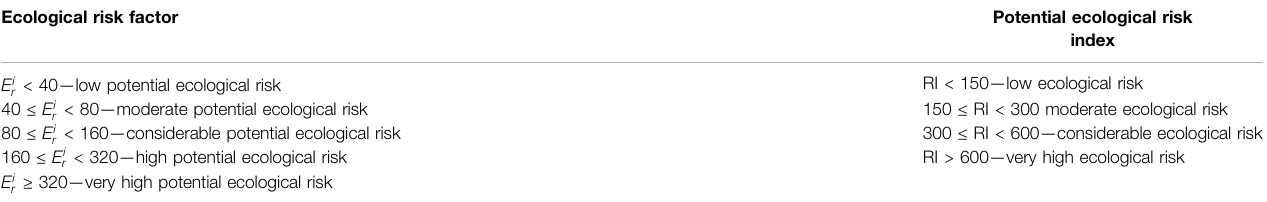
TABLE 2 | Terminology for the interpretation of Ecological risk factor ( E i r ) and potential risk index (RI) values (Zhou et al., 2020). Ecological risk factor